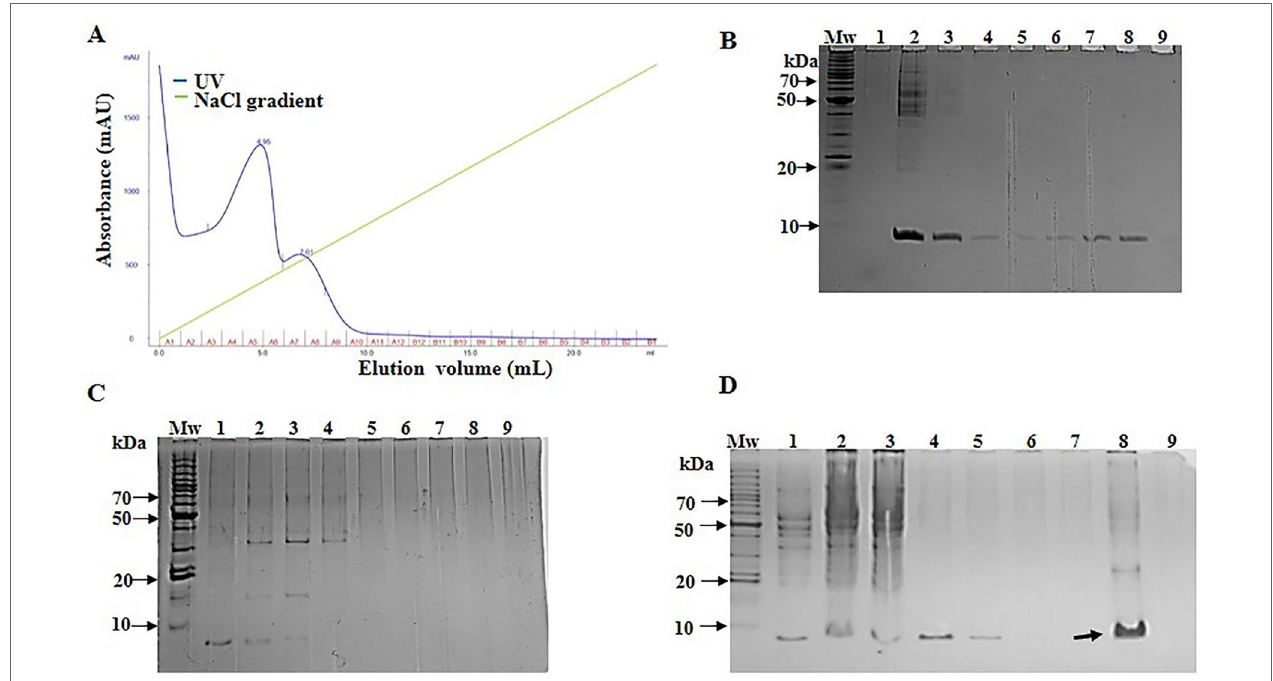
FIgUrE 4 | NLE-SCI-57 purification and fraction analysis. (A) NLE SCI-57 cation exchange separation performed on SP-Sepharose Fast Flow. Five ml of the sample was loaded. Elution fractions were 1 ml, and the flow rate was set at 0.4 ml/min 100 mM citrate buffer pH 4.3 (elution with 0–1 M linear NaCl gradient). Absorbance was expressed in milli-absorbance units for the A280 (blue line). Fractions were labeled by the A–B letters from 1–12 numbers. (B) 13% Coomassie stained Glycine SDS-PAGE gel, on which NLE-SCI-57 elution fractions were resolved. Mw: Molecular weight marker; lane 1:3.5 μg recombinant human insulin (PISA pharmaceutical, México); lane 2,3: Flow through from the column; from lane 4 to 8: Fraction A1 to A5 respectively from SCI-57 purification by cation exchange. (C) 13% Coomassie stained Glycine SDS-PAGE gel, on which NLE-SCI-57 elution fractions were resolved. Mw: Molecular weight marker; from lane 1 to 9: Fraction A6 to B11 respectively from SCI-57 purification by cation exchange. (D) 13% Coomassie stained Glycine SDS-PAGE gel, displaying ultrafiltrated A2–A7 fractions obtained by the SCI-57 purification by FPLC. Mw, Molecular weight marker, lane 1; NLE SCI-57, lane 2, NLE SCI-57 concentrated with 3 kDa membrane, lane 3: Flow through from the column, lane 4 to 7: Fraction A1 to A4, lane 8: Sample containing A2–A7 fractions ultrafiltrated with 3 kDa membrane, and analyzed by HPLC. 5 μL molecular weight marker and 20 μL of each fraction were loaded on the gel. Arrow indicates the protein corresponding to